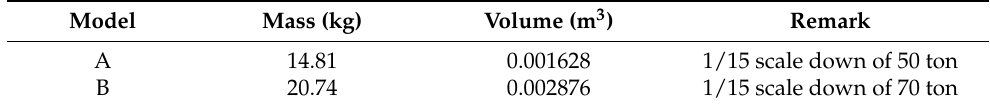
Table 4. Dimensions of crusher models.